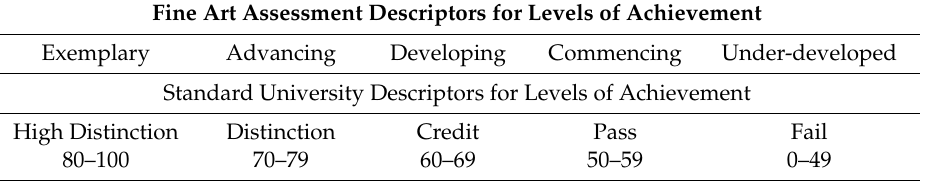
Table 2. Fine Art Levels of